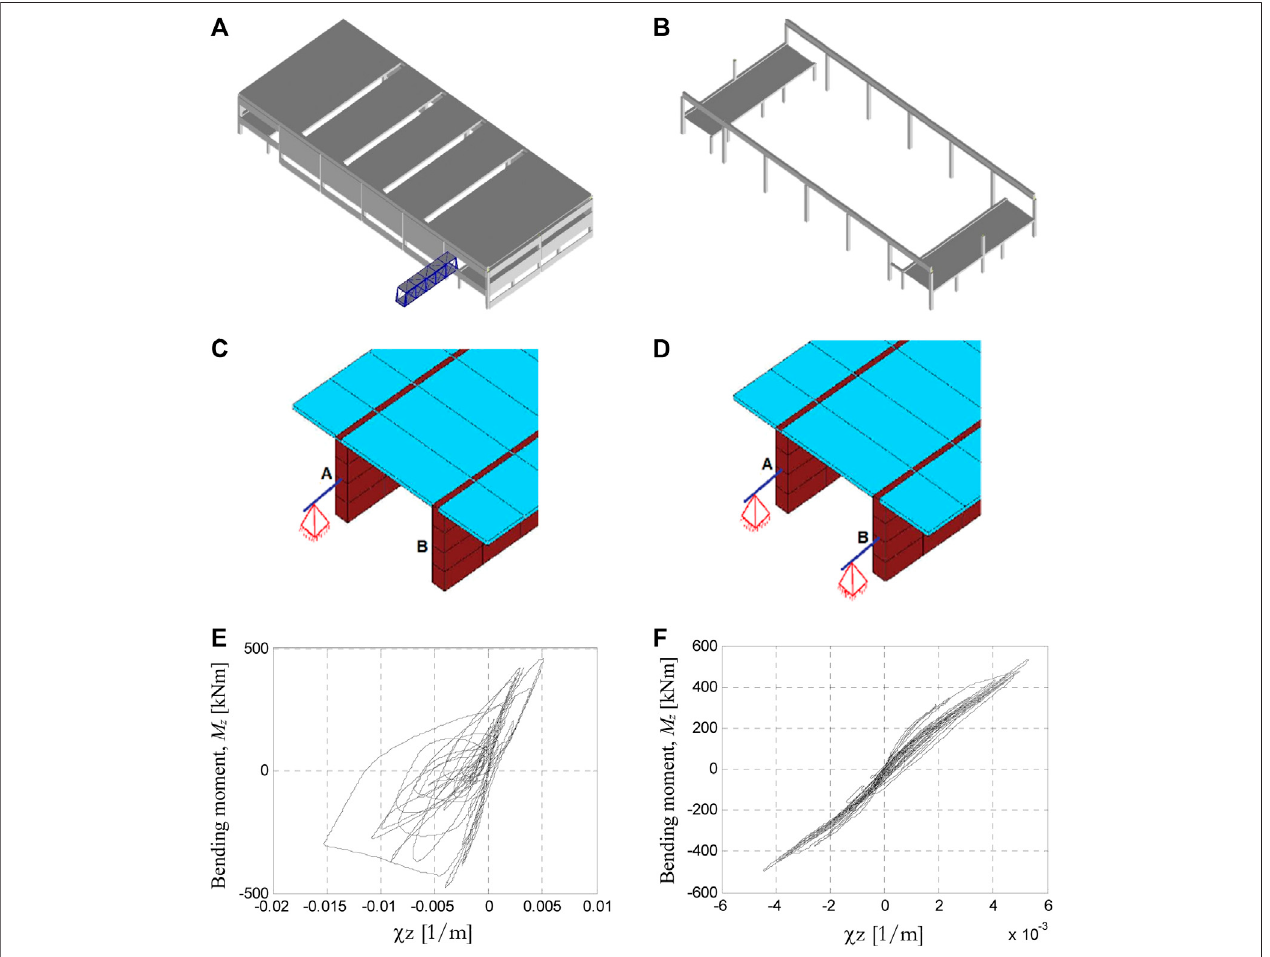
FIGURE12| FEmodelofaprecastbuildinglocatedintheScienti fi c-TechnologicalcampusoftheUniversityofFerrara:globalmodel (A) showingand (B) hidingroof elements and cladding panels; end support of a Pi-shaped roof element with connections to the main beams applied to (C) one single web or (D) both webs. Moment- curvature cyclic diagram at the base of one of the columns obtained from NRH analysis (E) before and (F) after retro fi tting.